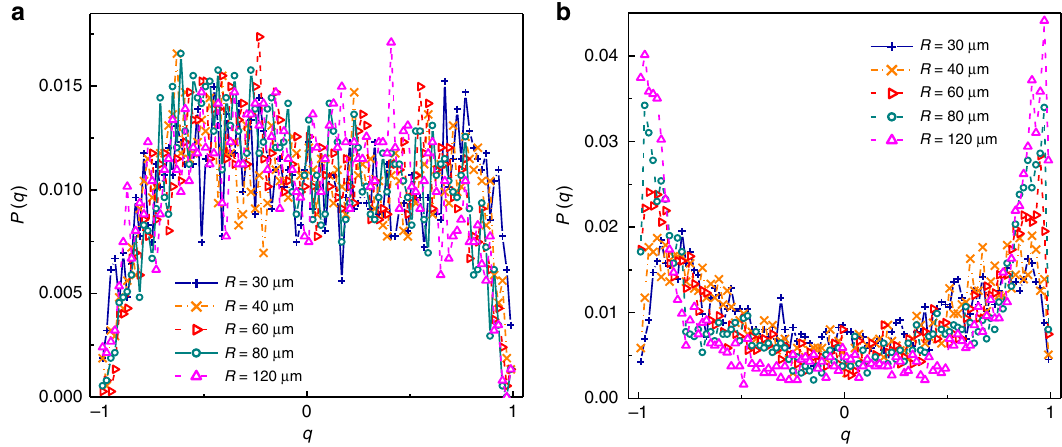
Fig. 4 Stability of replica symmetry breaking. a P ( q ) for different cut-off scales R at t < t c (paramagnetic-like phase) and b at t > t c (spin-glass-like